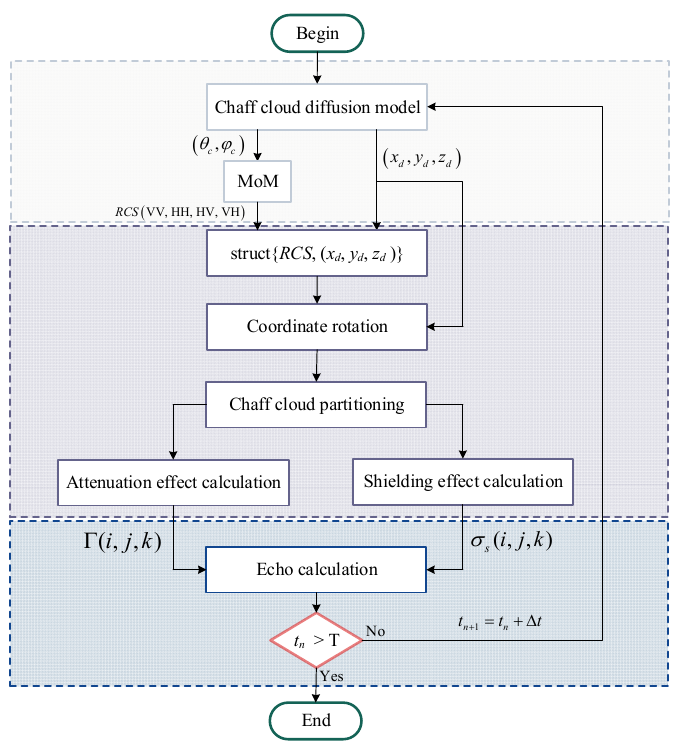
Figure 8. The chaff cloud radar echo simulation flow chart.